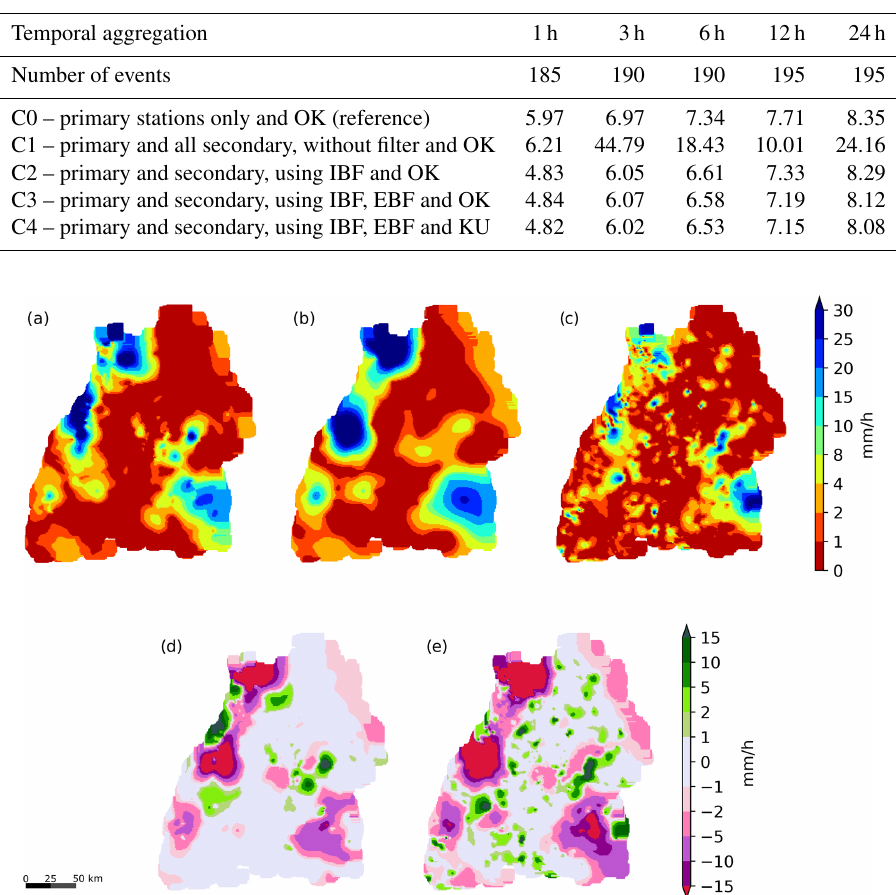
Figure 9. Interpolated precipitation for the time period from 15:00 to 16:00LT on 11 June 2018 (a–c) and the differences between primary and combination and primary and secondary data-based interpolations. Panel (a) shows the result after applying the filtering, (b) the interpolation from the primary network and (c) the one from the secondary network. Panels (d) and (e) depict the differences between (a) and (b) and (c) and (b) , respectively.